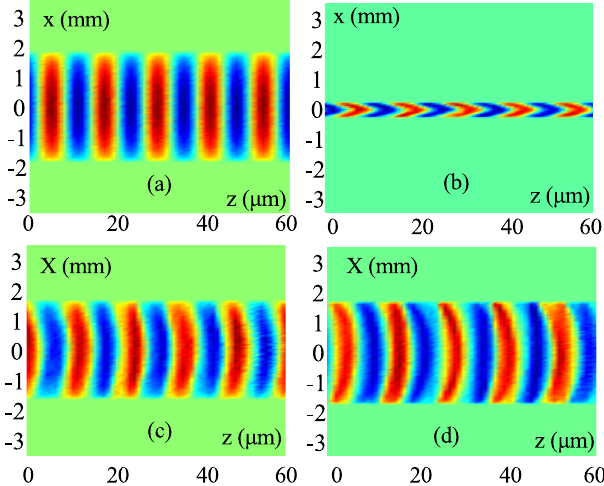
FIG. 8. Projection on the z-x plane of the evolution of the 25 THz periodic e-beam density modulation (case 1 in Table I). The background density is subtracted, and only variation of the density (ac portion) is shown: the red color corresponds to increased beam density and the blue to reduced beam density. Color density is normalized to maximum values to accommodate its exponential growth. (a) At the system entrance; (b) in the middle of the second cell (beam waist); (c) after the third cell, and (d) after the four-cell system. The electron beam is azimuthally symmetric: in the figures above, z is the longitudinal coordinate with respect to the beam center, while x is one of the transverse